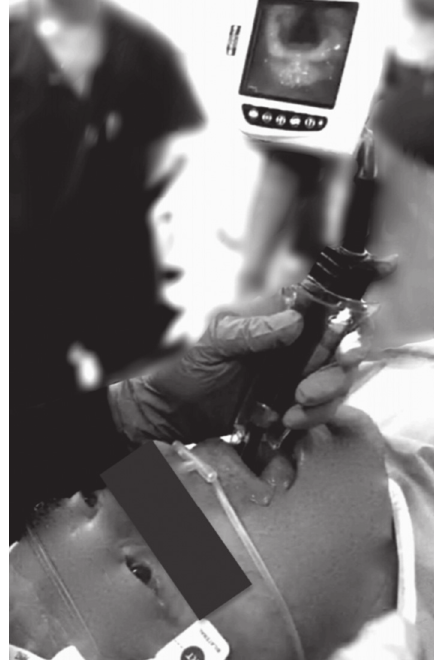
Figure 2: View of glottis with video laryngoscope (Glidescope ® ). The sedated patient under spontaneous breathing (Case